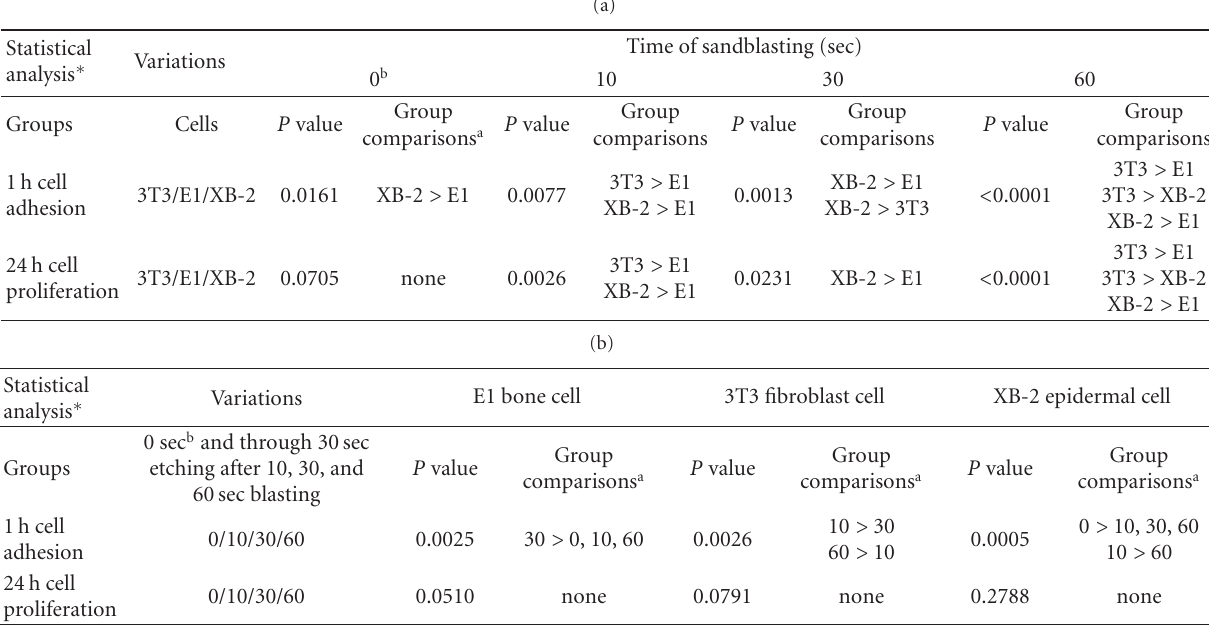
Table 1: One-way ANOVA statistical analysis of the control group (0sec) and test groups using 30 sec of acid etching after 10, 30, and 60sec of sandblasting for samples from bone E1, fibroblast 3T3, and an epidermal cell XB-2 cells after 1 and 24h ( n = 5).